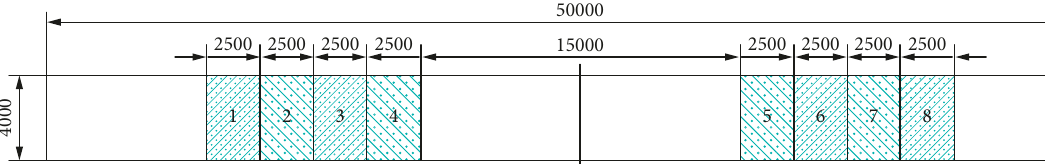
Figure 1: Lane layout.